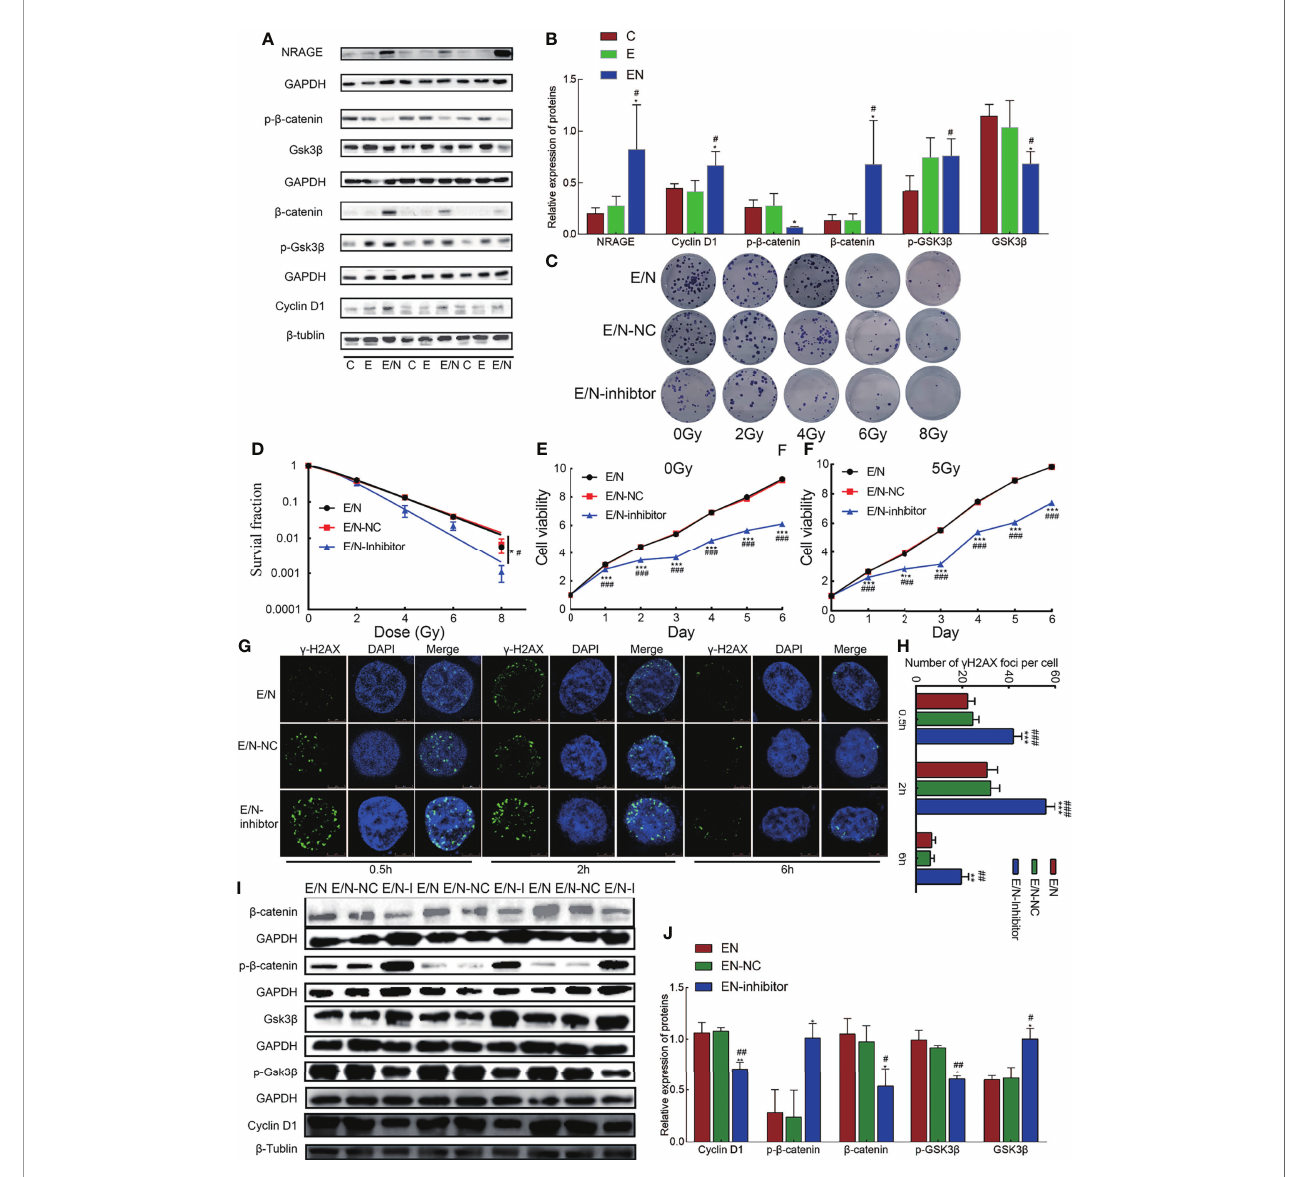
FIGURE 3 | Overexpression of NRAGE activates canonical Wnt signaling pathways in ESCC cells with 2D culture. (A) The expression of Wnt/ b -catenin signaling pathway-related proteins was determined using western blotting. (B) Quantitative assessment of related proteins in Wnt/ b -catenin signaling pathway. All data represented as means ± SD. * p < 0.05 vs. E; ** p < 0.01 vs. E; *** p < 0.001 vs. E, # p < 0.05 vs. C; ## p < 0.01 vs. C; ### p < 0.001 vs. C. (C) Representative images of colony formation of E/N cells after exposure to radiation with or without FH535. (D) Dose – response curves were fi tted according to the multi-target, single-hit model and analyzed using GraphPad Prism 8.0 software. (E, F) growth curve was detected by CCK-8 analysis in EN cells with or without FH535 by different irradiation doses with 0 and 5 Gy. (G, H) The formation of g -H2AX foci at 0.5, 2, 6 after 5 Gy irradiation in EN cells with or without FH535. (I, J) Western blotting analysis the expression of Wnt/ b -catenin signaling pathway-related proteins with or without FH535. All data represented as means ± SD. * p < 0.05 vs. EN; ** p < 0.01 vs. EN; # p < 0.05 vs. EN-NC; ## p < 0.01 vs.